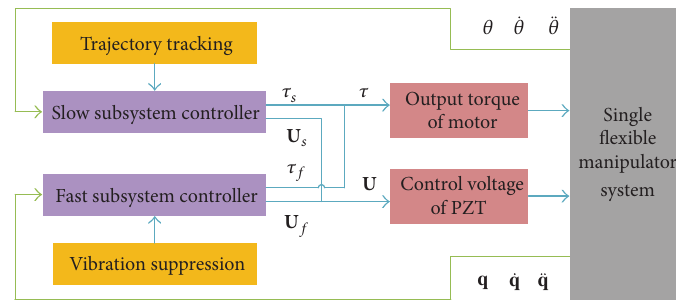
Figure 3: Structure diagram of the composite controller.